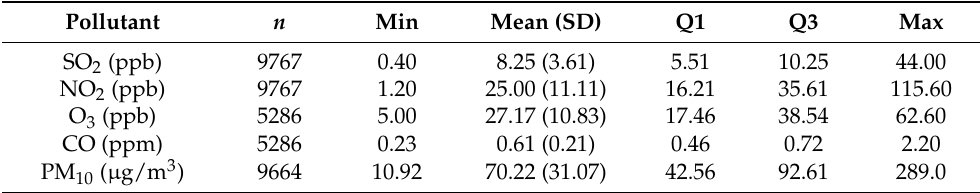
Table 2. Status of environmental pollutants which our subjects exposed